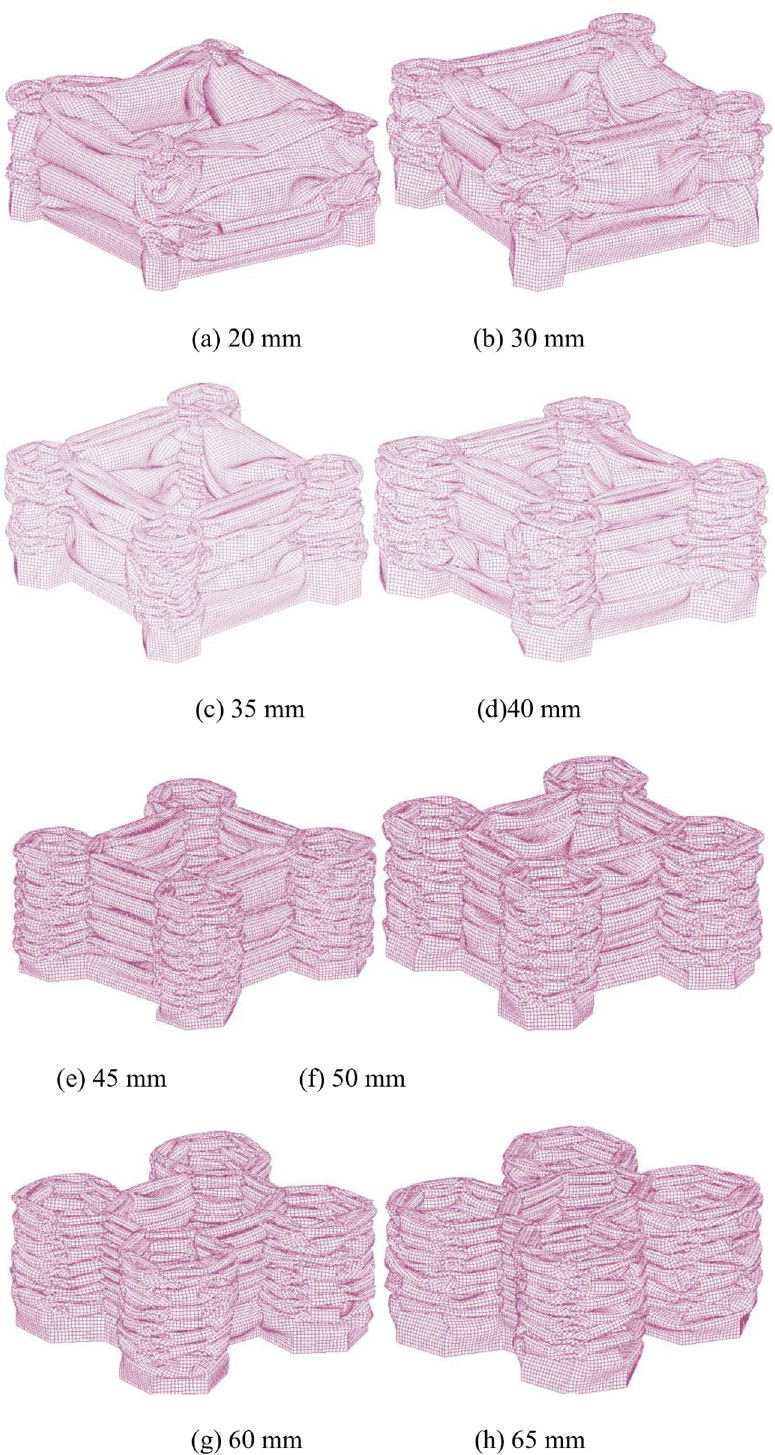
Fig 9. Deformed shapes of the tubes with different corner-cell sizes.